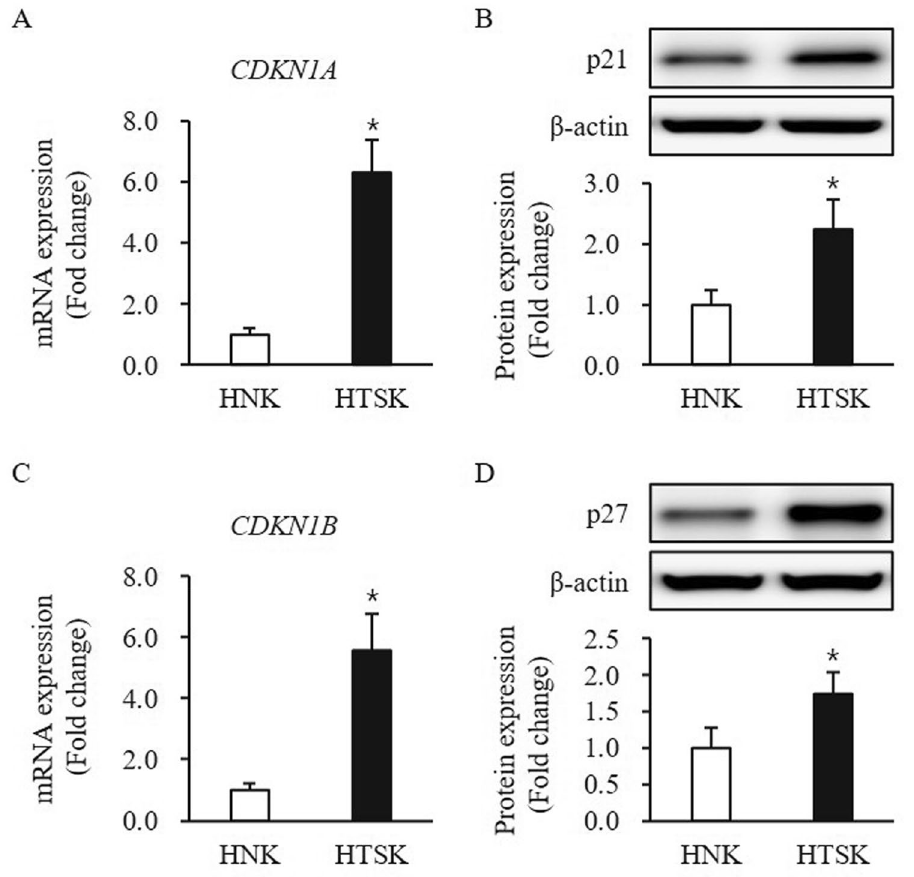
Figure 4. Expression of proliferation/differentiation regulators in HTSKs. Significantly decreased mRNA levels of genes encoding p21 ( CDKN1A ) (A) and p27 ( CDKN1B ) (C) in HTSKs compared with those in HNKs. Significantly decreased protein levels of p21 (B) and p27 (D) in HTSKs compared with those in HNKs. NHKs and HTSKs were primary cultured from normal skin tissues and HTS tissues, respectively. In the fold change, HNKs marked as value 1; HNK, human normal keratinocyte; HTSK, hypertrophic scar keratinocyte; * P < 0.05 for HTSK vs. the corresponding matched HNK. Data represent means ± SD; n = 4 (HNK) and n = 4